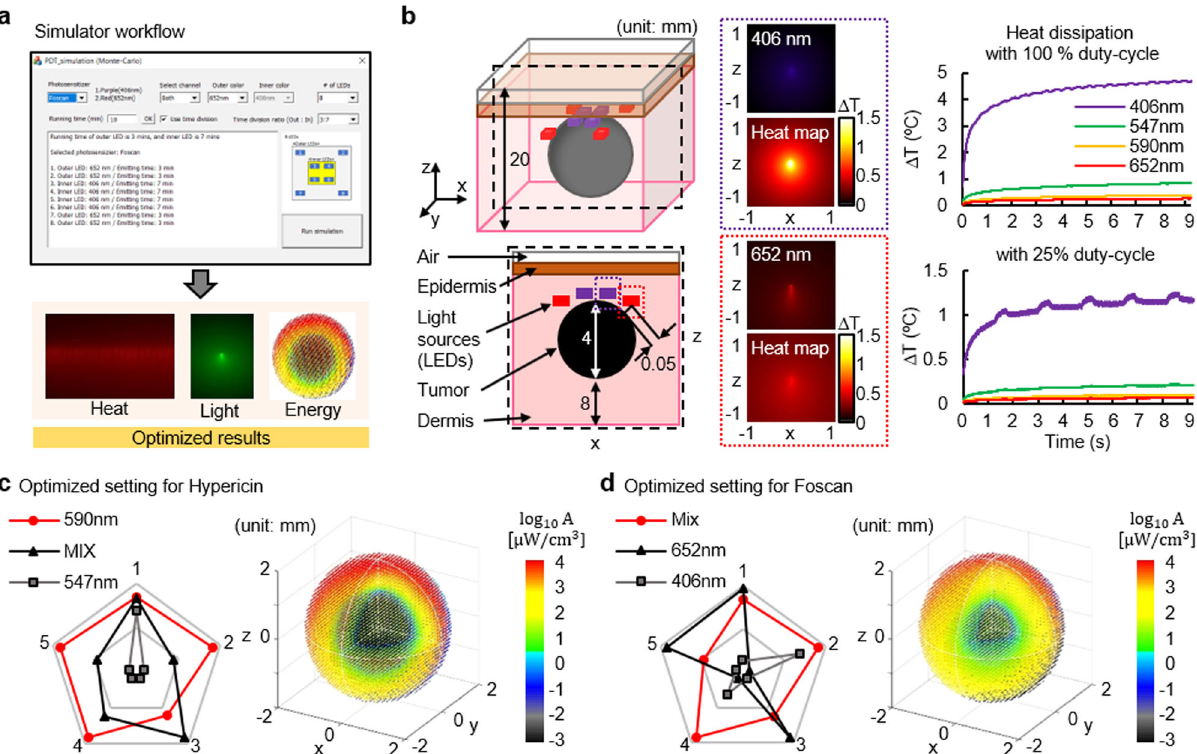
Fig. 2 MC simulation for light delivery and heat management. a Overview of the integrated MC simulator. The simulation platform processes parameters from a user and performs analysis of thermal dissipation, light propagation, and energy absorption. One can determine the best PDT regimen to be the most effective in activating a photosensitizer. b Three-dimensional and cross-sectional view of a tumor-tissue model (left). Light scattering and heatmap at a wavelength of 406 nm and 652 nm, respectively for activation of Foscan (middle). Plots of variation in temperatures as a function of time during each mode of operation; constant and 25 Hz with 10 ms on (right). The best PDT regimen for activation of Hypericin c and Foscan d . Five criteria include 1. degree of light penetration, 2. rate of energy absorbance, 3. level of uniformity of energy absorbance into a tumor cell, 4. the time required for delivery of targeted light energy, and 5. range of temperature